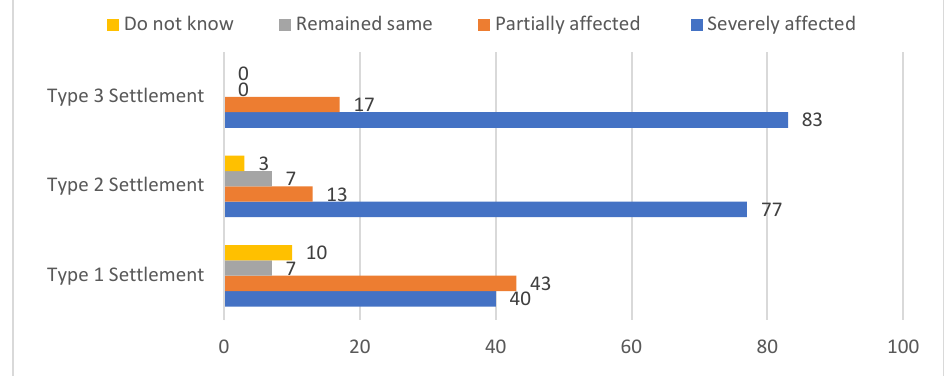
Figure 2. Perception (in %) of respondents (n = 90) on the overall impact of a hypothetical flood on their livelihood in three settlements through a four-point Likert scale ranging from ‘Severely affected’ to ‘Do not know’. Source: survey.